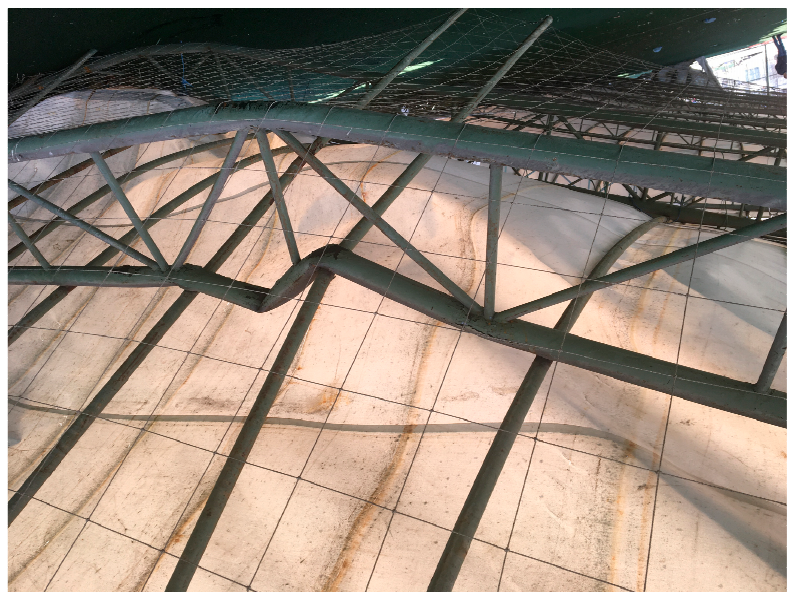
Figure 11. Bending moment e ff ect observed in purlin connections to the rafters.